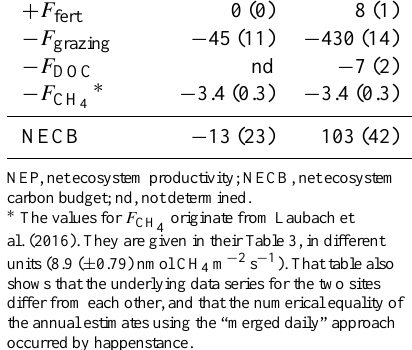
Table 3. Carbon gains and losses (g Cm − 2 yr − 1 ) , and their un- certainties in parentheses, for the UUW and IFR pasture, including NEP, grazing ( F grazing ) , animal excreta ( F excreta ) , fertiliser ( F fert ) , leaching of dissolved organic C ( F DOC ) , and methane from soil and ) . Negative numbers indicate a loss of carbon from the excreta ( F CH 4 pasture ecosystem.